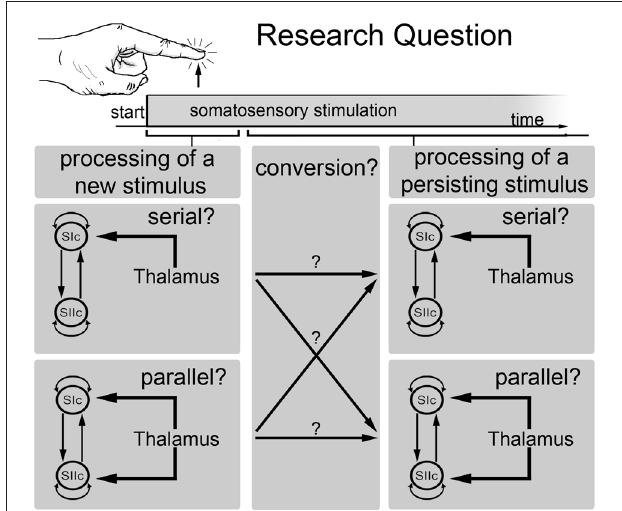
FIGURE 1 | Schematic outline of the main research question of the current study. This study investigated whether somatosensory information is processed in parallel or in series and whether the processing mode changes over time. Specifically, whether the processing mode at the beginning of a new stimulus is different from the processing mode of a persisting